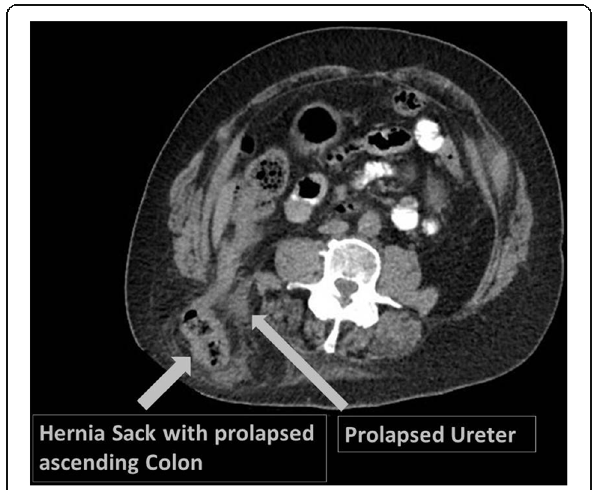
Fig. 1 Preoperative CT revealed a large Grynfeltt hernia with prolapse of the ascending colon and the right ureter with consecutive dilatation of the renal pelvis